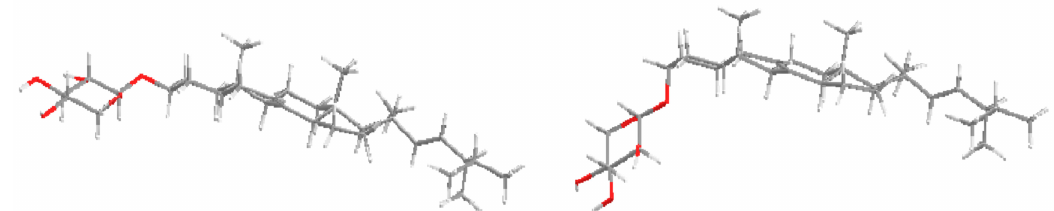
Figure 2. Graphical representation of structures of DHE-xylose 7(left) and 3- epi -DHE-xylose 8(right) by DFT calculation. Grey (carbon), white (hydrogen), and red (oxygen)